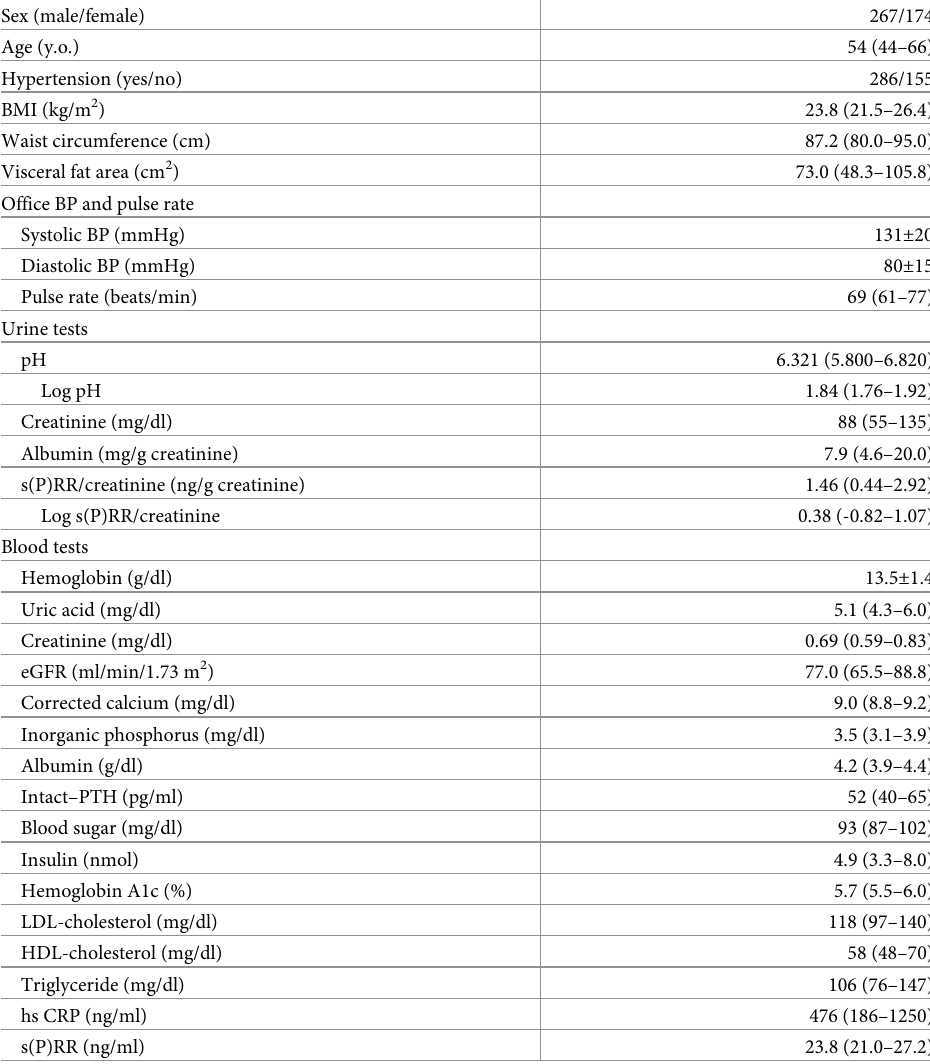
Table 1. Characteristics of the study